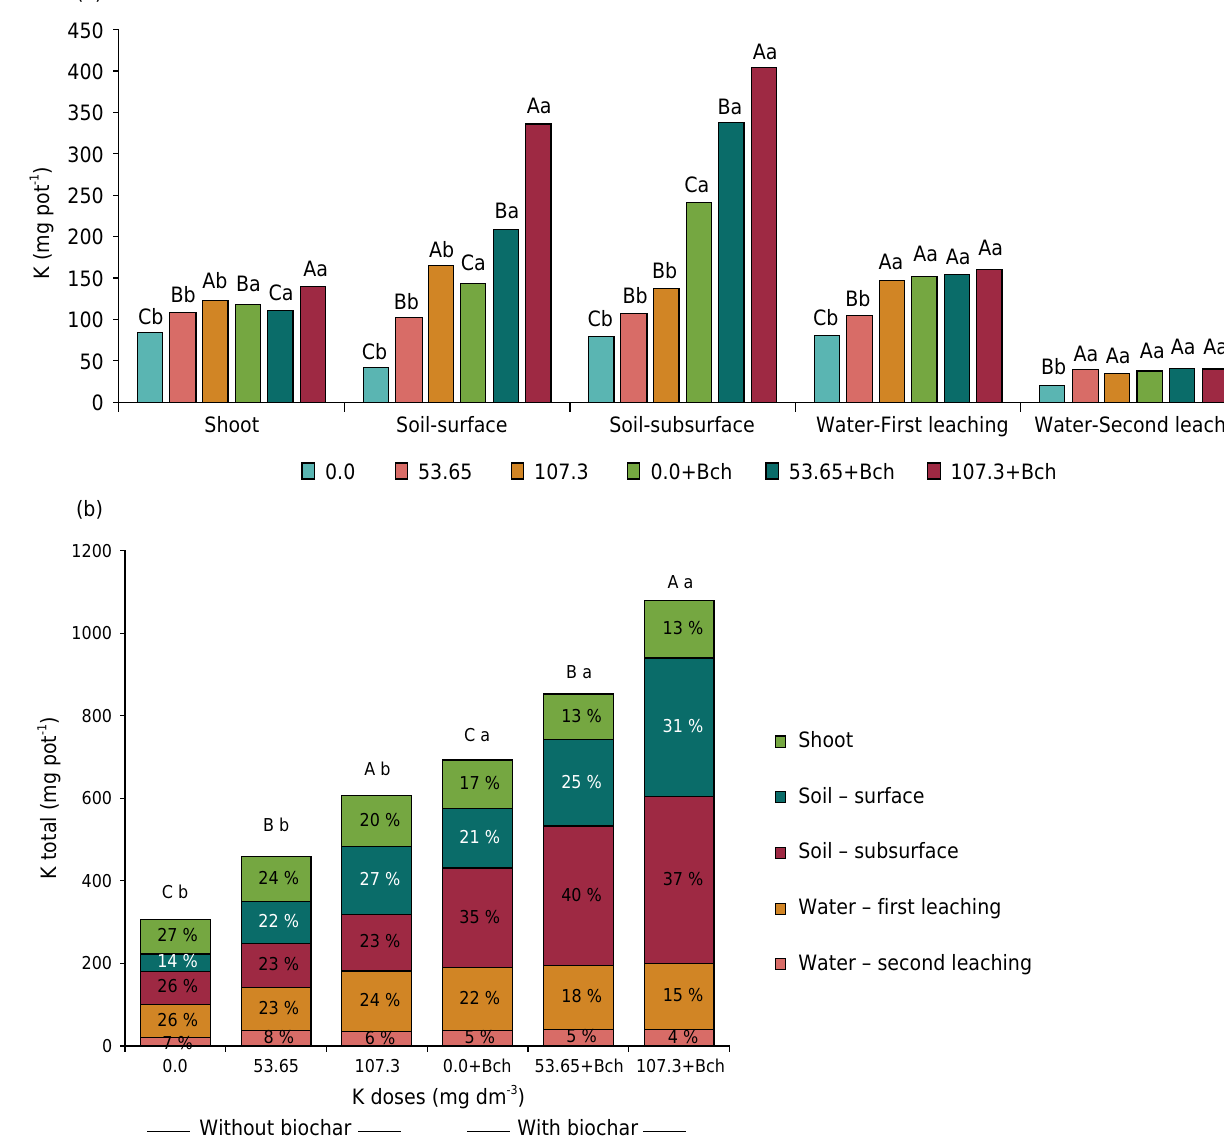
Figure 6. Potassium content in the shoot plants of mucuna, in the surface and subsurface soils of the pots (after cultivation) and in the water of the first leaching (after the incubation period) and in the water of the second leaching (performed after the harvest of mucuna), after treated with or without biochar associated with three levels of K (a). Total content of K in the soil-plant-water system (obtained by the sum of the K accumulation in the plant shoots + K content in the soil + K content in the leached water) and proportion of total content accumulated by parts: soil-plant-water ratio (b). Differences between the three K doses for treatments with or without biochar are indicated by capital letters. Differences between treatments with or without biochar at each dose of K are indicated by lowercase letters, both by the Tukey’s test at 5 % (mean of 6 repetitions).